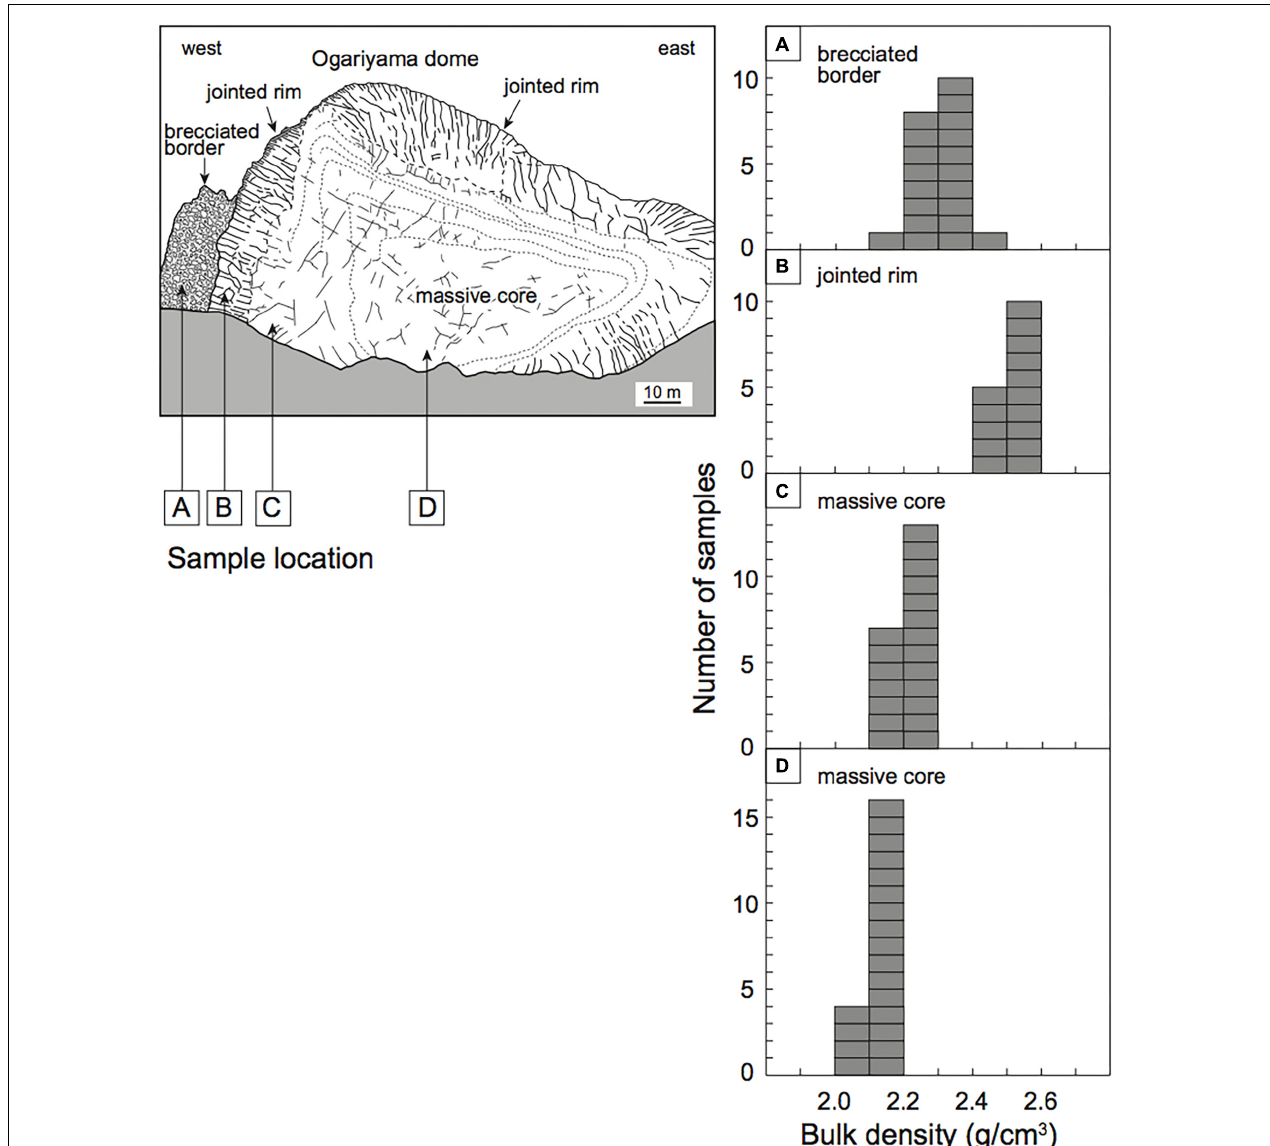
FIGURE 9 | Bulk densities of the rhyodacites from the (A) brecciated border, (B) jointed rim, and (C,D) massive core. Sampling positions (A–D) are shown in the